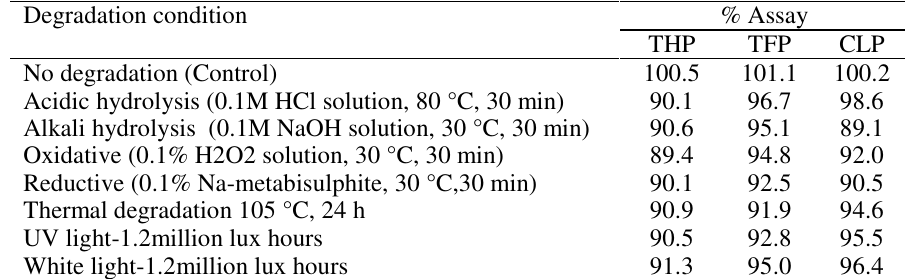
Table 2. Forced degradation study